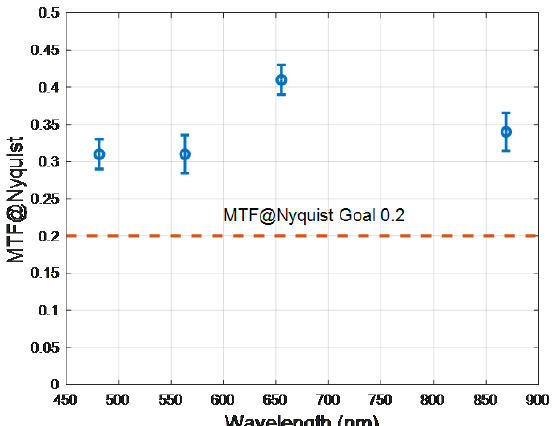
Figure 21. DESIS in-flight MTF@Nyquist in the cross-track direction. Values plotted are means and standard errors of 30 in-scene